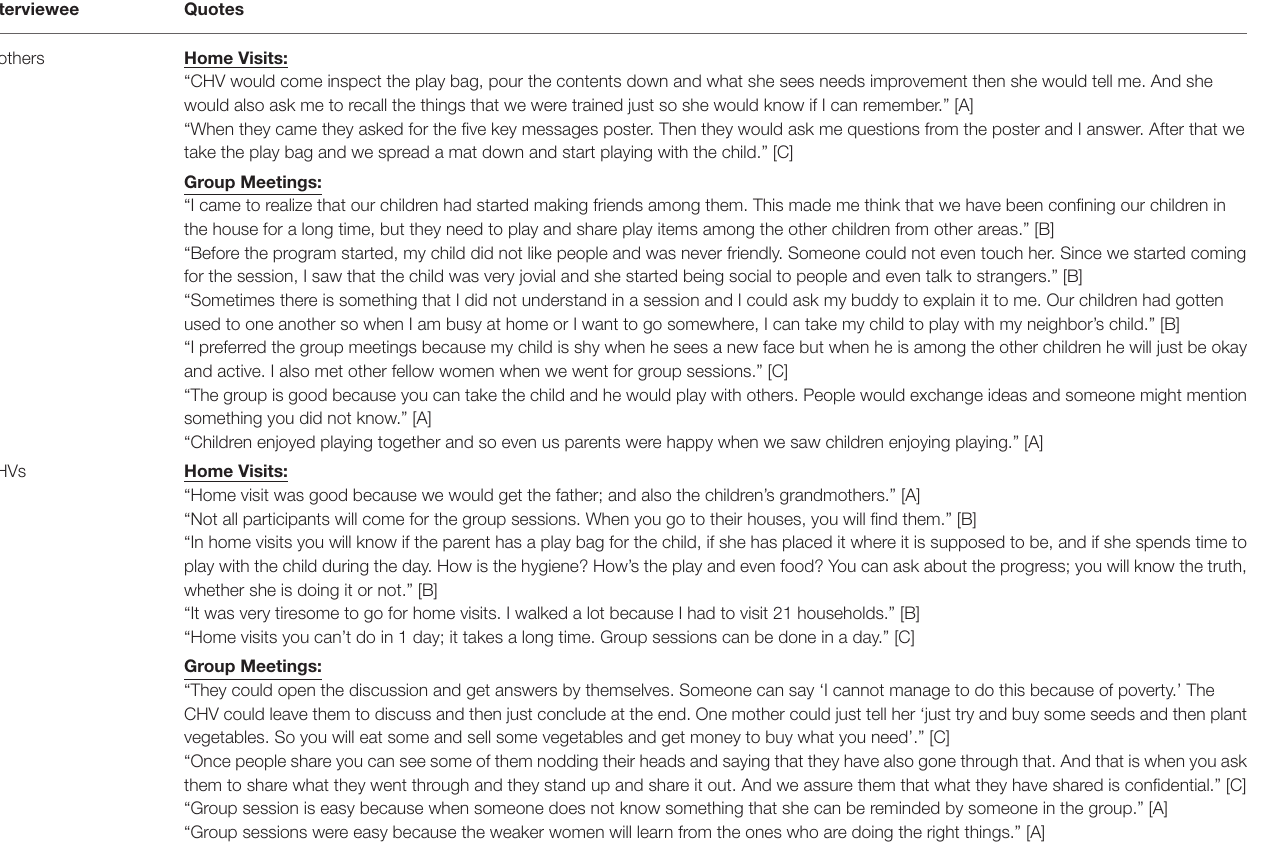
TABLE 8 | Mother, CHV, and supervisor perceptions about home visit vs. group meetings.